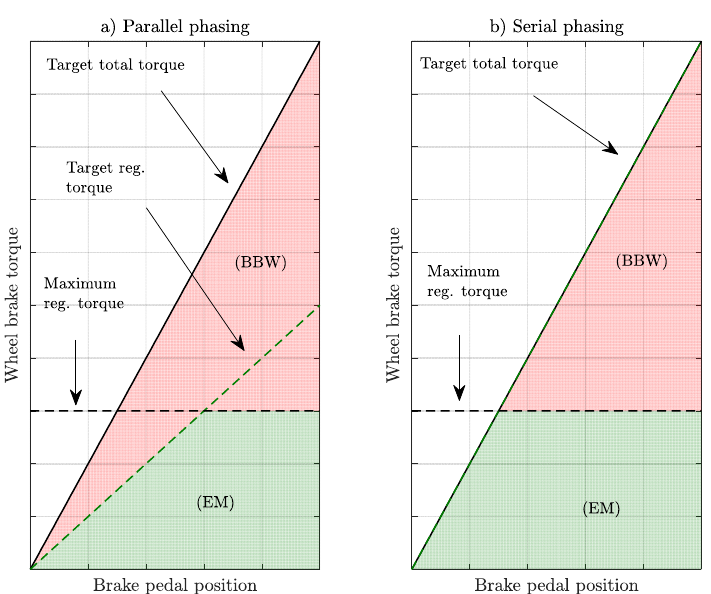
Figure A1. Results of the vehicle mass and road slope observer test run.